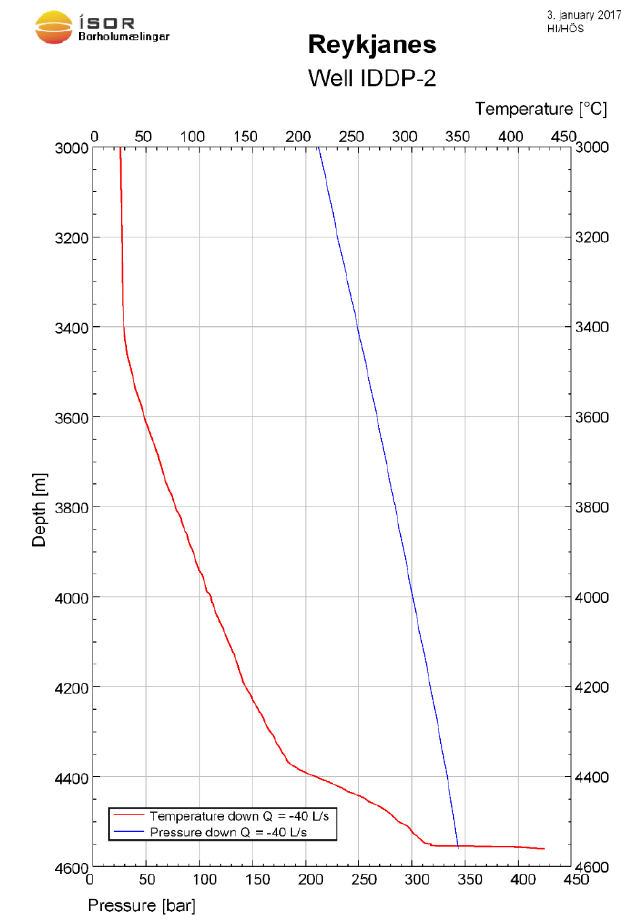
Figure 5. Temperature and pressure log to 4560m depth in IDDP-2 after only 6 days of heating. As can be seen from the temperature profile, the well is far from thermal equilibrium because of cold wa- ter injection. When thermal recovery is complete, it is likely that temperatures will exceed the estimated 426 ◦ C measured at the bot- tom of the hole. The PT logging was done with a K-10 logging tool, which was calibrated to only 380 ◦ C (Weisenberger et al.,